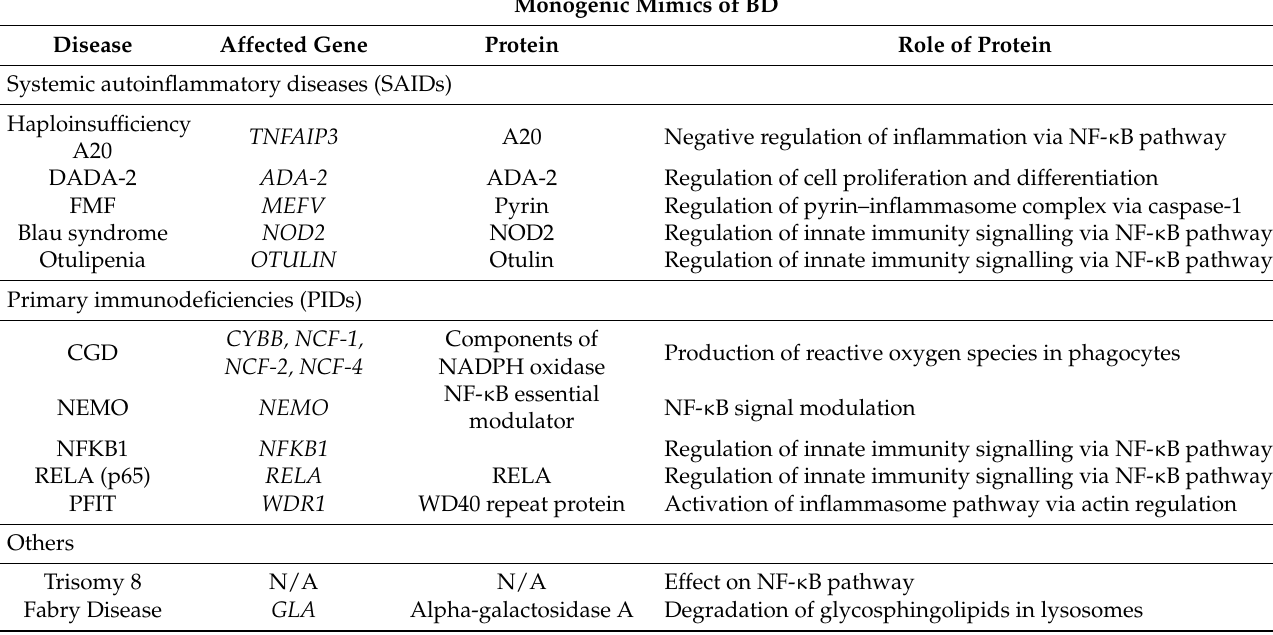
Table 2. Monogenic mimics of BD with affected gene and protein. Monogenic Mimics of